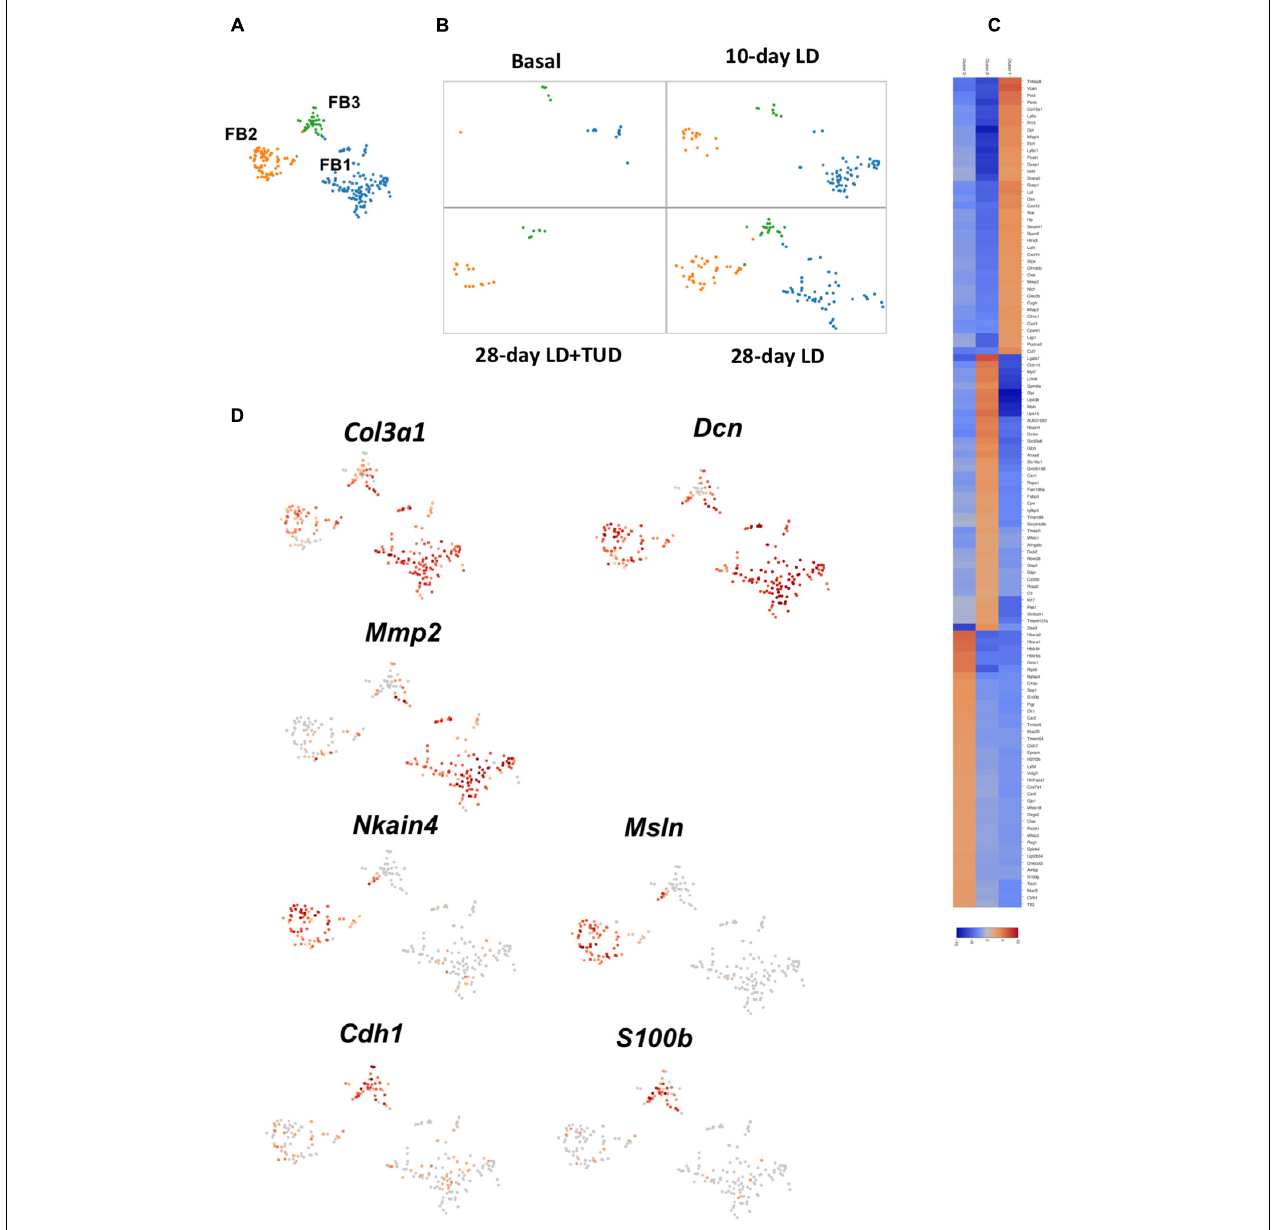
FIGURE 7 | Sub-clustering analysis of the transcriptome pattern of fibroblasts. (A) t-SNE plot showing three sub-clusters of fibroblasts in gallbladder. (B) t-SNE plot showing the dynamic transcriptomic patterns of fibroblasts during gallstone formation and under TUDCA treatment. They emerged upon LD feeding at day 10 and day 28, but diminished under TUDCA treatment. (C) The heatmap indicated enriched expressions of marker genes in each sub-cluster of fibroblasts according to their transcriptome pattern. (D) t-SNE plot highlighting the sub-clusters of fibroblasts according to representative markers. Cells in all three sub-clusters expressed pan-markers for fibroblast cell such as collagens ( Col1a1 , Col3a1 ) and proteoglycans ( Dcn ). The expression of calcium binding protein S100b suggested the presence of mesenchymal cell to epithelial cell